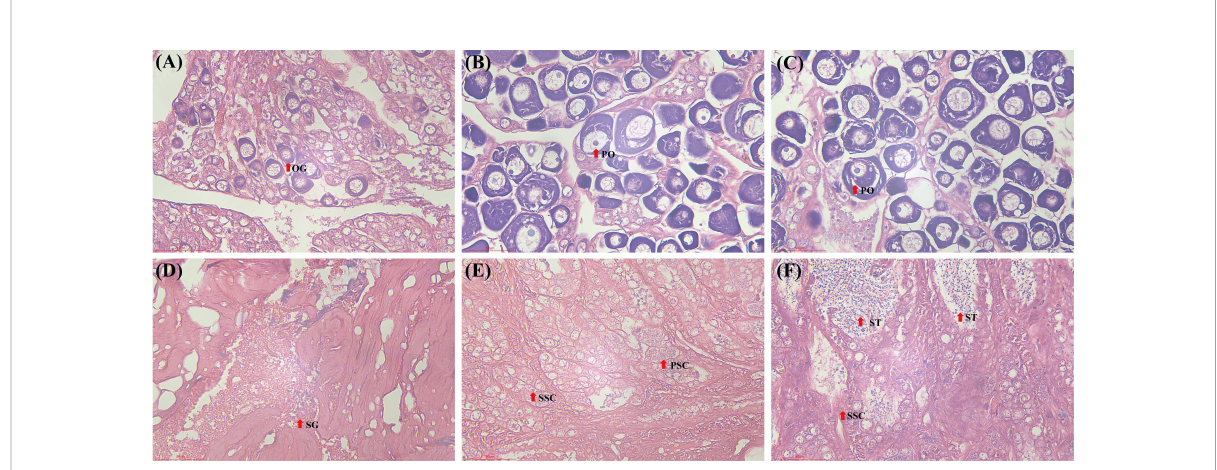
FIGURE 2 The histological changes of gonads in golden pompano between 5 and 9 months of age. (A) 5-month-old ovary; (B) 7-month-old ovary; (C) 9-month-old ovary; (D) 5-month-old testis; (E) 7-month-old testis; (F) 9-month-old testis; OG, oogonia; PO, primary oocytes; SG: spermatogonia; PSC, primary spermatocytes; SSC, secondary spermatocytes; ST,